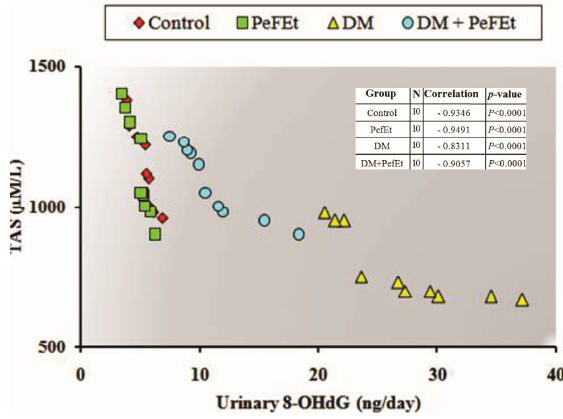
Fig. 1. The correlation of urinary 8-OHdG with TAS The urinary 8-OHdG was independently correlated with TAS in all the groups. The negative correlation was highly significant (p<0.0001) in all the four